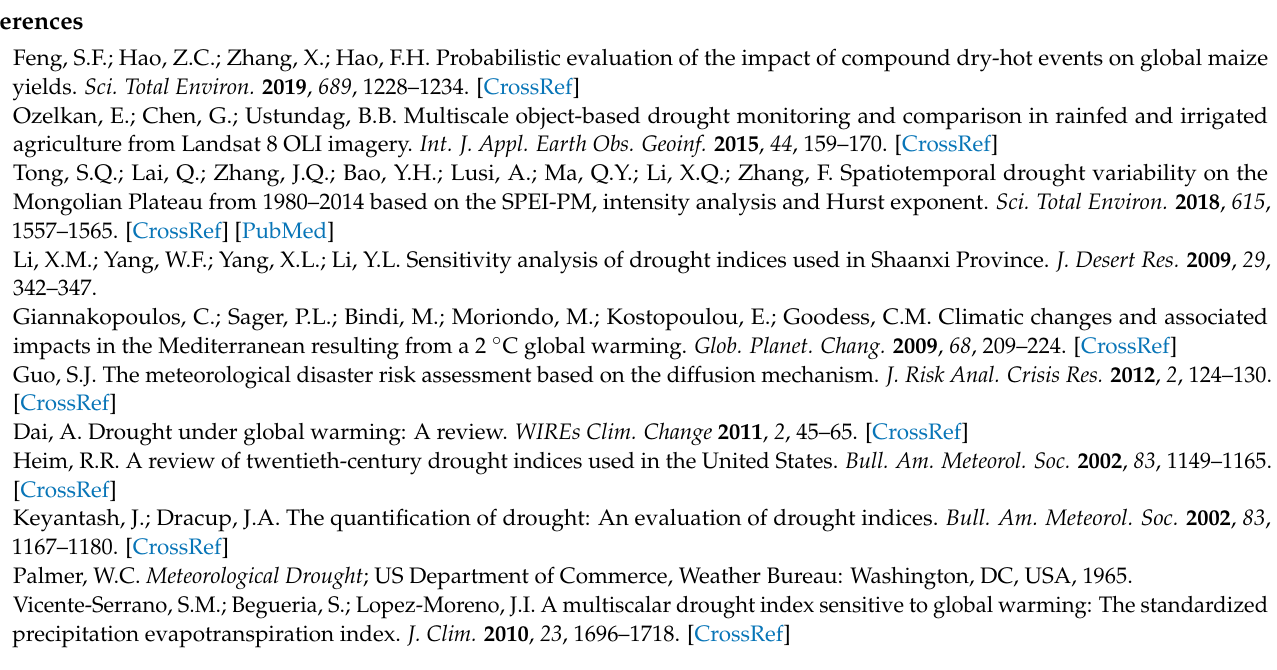
Table S1: Teleconnection indices used in this study with their full name, time period and source; Table S2: Variance contributions of the un-rotated and rotated components based on monthly scPDSI; Table S3: Drought trend based on MK and Sen’s